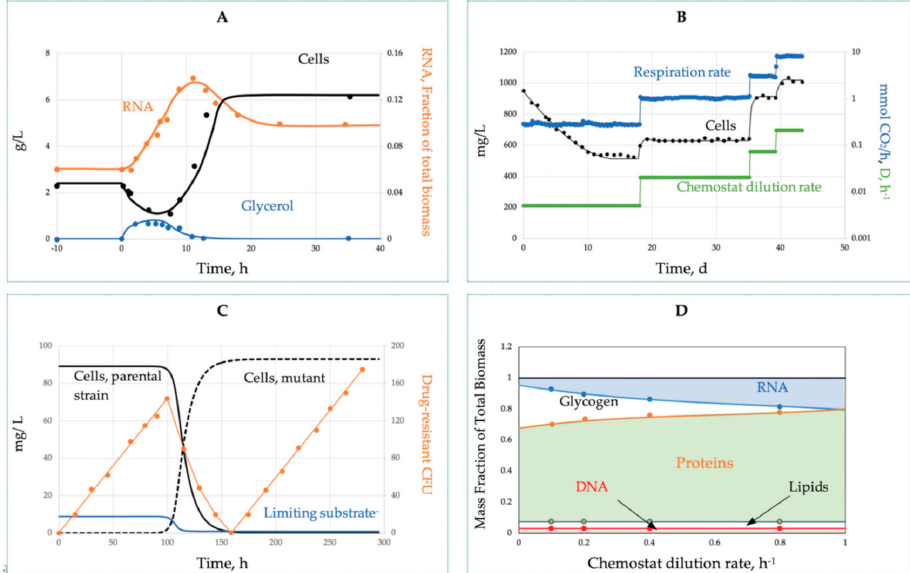
Figure 3. Unbalanced and non-steady-state growth in a continuous culture. ( A ) The shift-up exper- iment in a chemostat culture of Aerobacter aerogenes limited by glycerol; at time zero, the dilution rate was changed from 0.004 to 0.24 h − 1 [62]. ( B ) Time series of the cell biomass and respiration (CO 2 formation rate) in a chemostat culture of E. coli K-12 after sequential changes of the dilution rates (Panikov, unpublished). ( C ) Spontaneous mutation and auto-selection in a chemostat. At t = 0, one out of ~10 11 cells mL − 1 underwent a beneficial mutation improving the substrate affinity ( K s declined), followed by a complete replacement of the parental strain. A genetic sweep was manifested by a decline of the substrate concentration and resetting of the linear accumulation of the drug-resistant cells (Panikov, unpublished rifampicin-resistant CFU data for Mycobacterium smegmatis ). ( D ) Changes in the cell composition of A. aerogenes grown in a NH4 + -limited chemostat culture as dependent on the dilution rate in a chemostat [62]. All curves were calculated using SCM. Plots A and D are reprinted with permission from [59]. Copyright (2019)